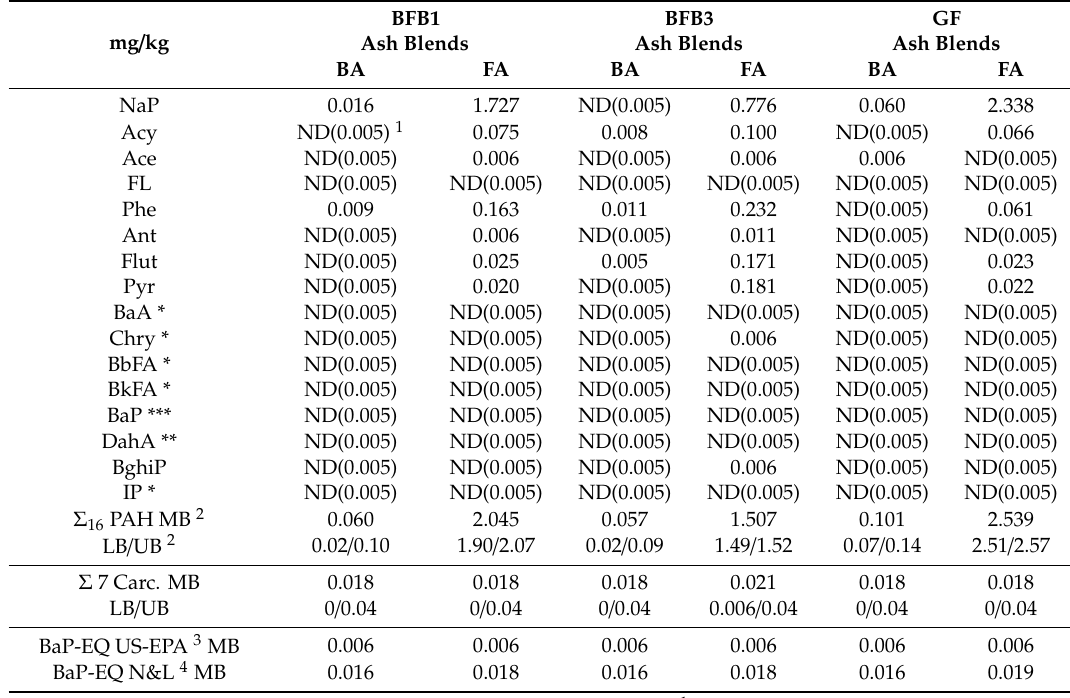
Table 8. PAHs, BaP-EQs of biomass ash blends, in dry